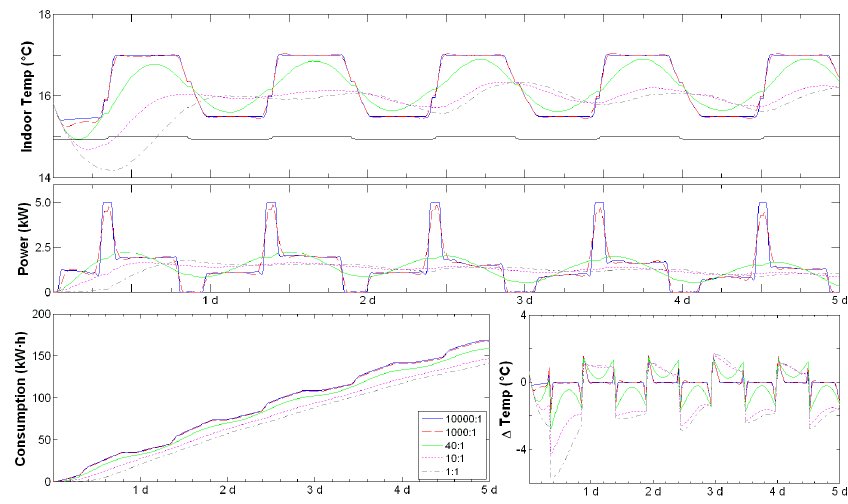
Figure 7. System response for different weight relation ( ∆ Reference:Control). Black Line represents the variations of the temperature of reference. Table 4 indicates the energy consumption of the system for the control with different weights.